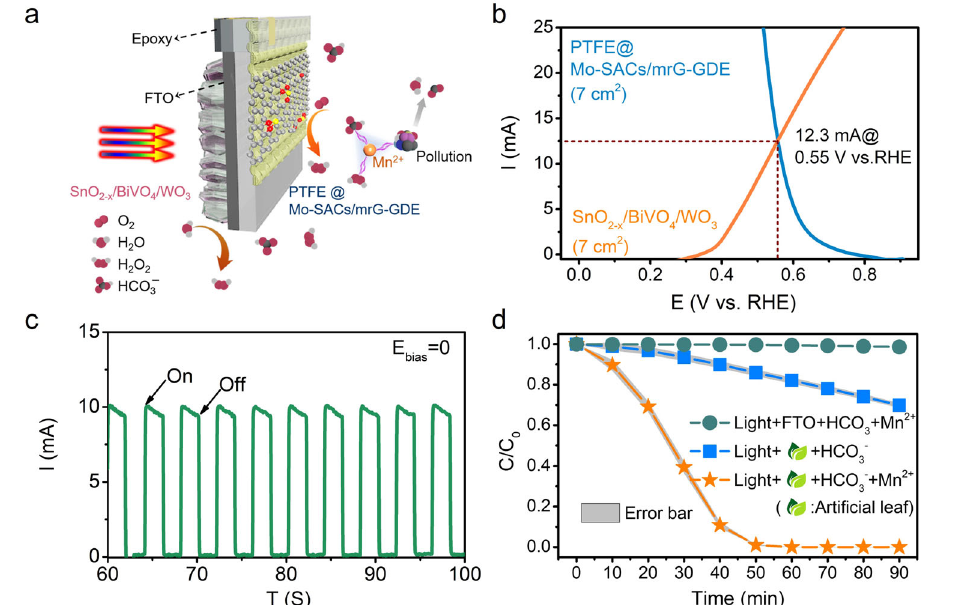
Fig. 6 | Design of a large arti fi cial leaf for PEC-driven wastewater treatment. a Schematic of the arti fi cial leaf for water treatment. b Coupled LSV scan of the SnO 2-x /BiVO 4 /WO 3 photoanode (7cm 2 ) and PTFE@Mo-SACs/mrG-GDE cathode